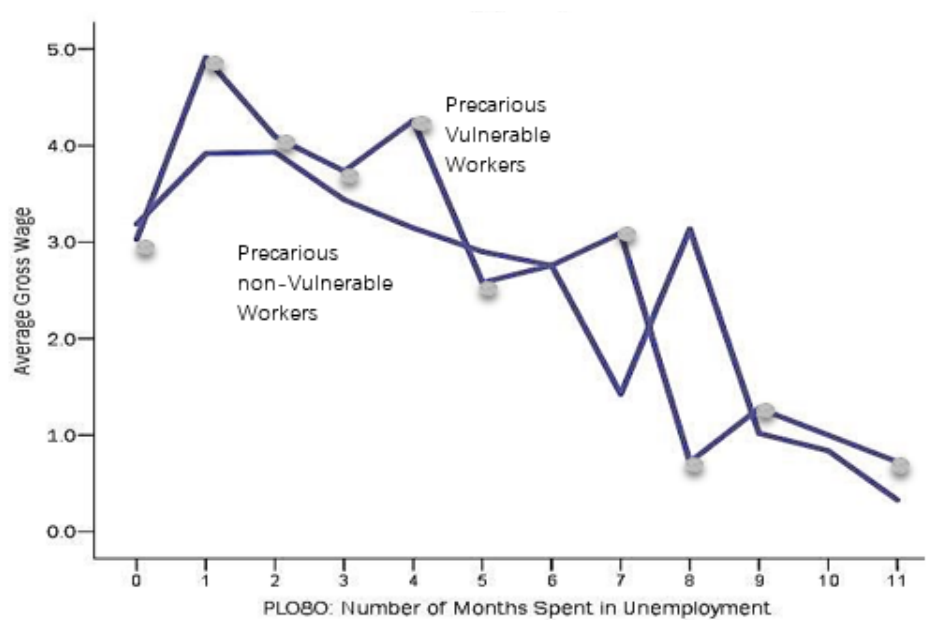
Figure 20. Annual gross wage as a function of duration of unemployment and economic vulnerability. Data source: Eurostat EU-SILC (2020).